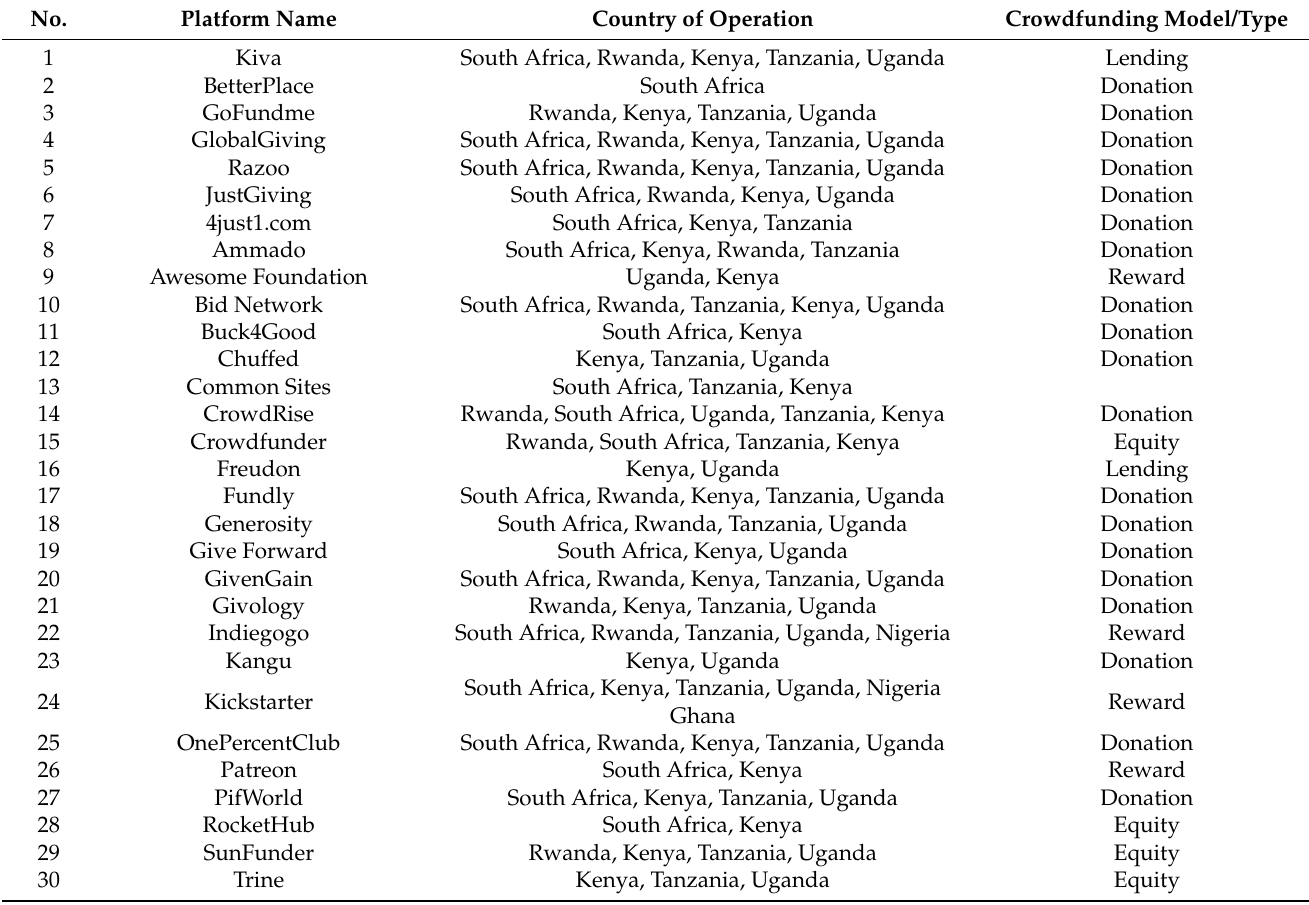
Table 8. International crowdfunding platforms operating in the African